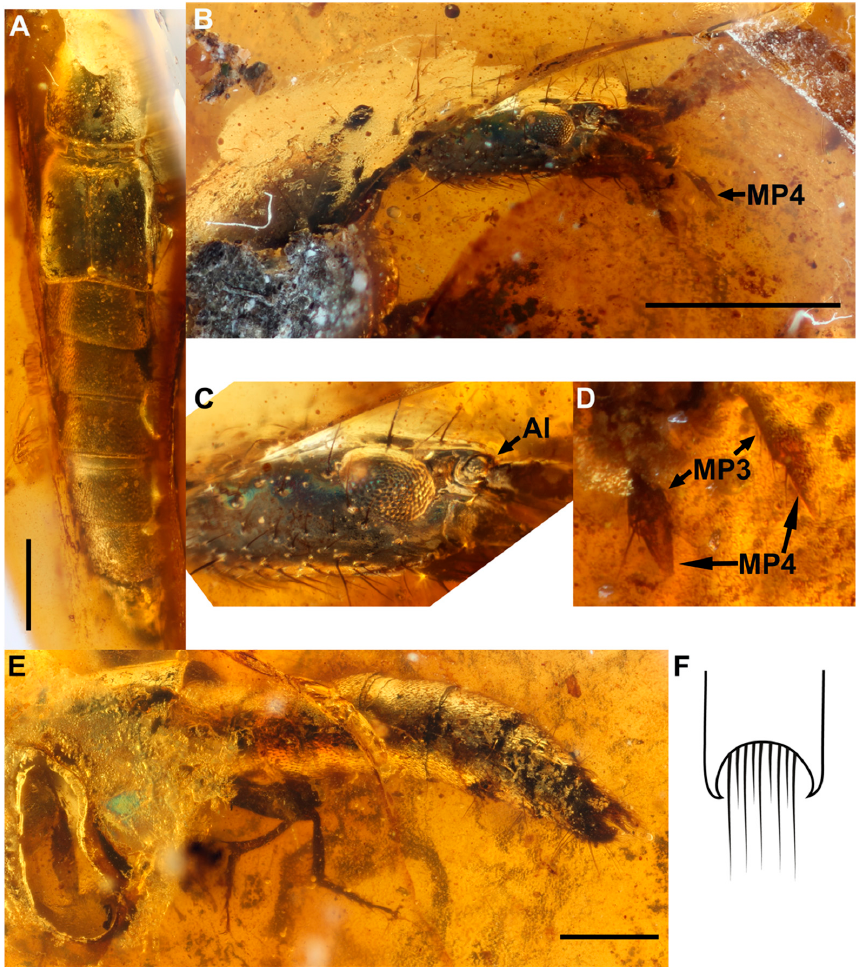
Figure 2. Coomania megistos sp. nov. Holotype SNUC-Paleo-0104. ( A ), dorsal view. ( B ), right side of head in lateral view. ( C ), close up of right side of head. ( D ), maxillary palpi. ( E ), left side of abdomen in lateral view. ( F ), drawing of tergite IX in dorsal view. Scale bars-1 mm. AI-antennal insertions; MP-maxillary palpomere.